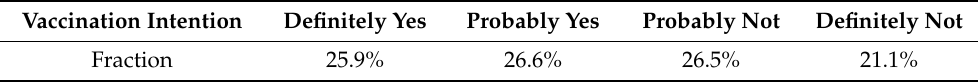
Table 2. Distribution of willingness to get vaccinated. Vaccination Intention